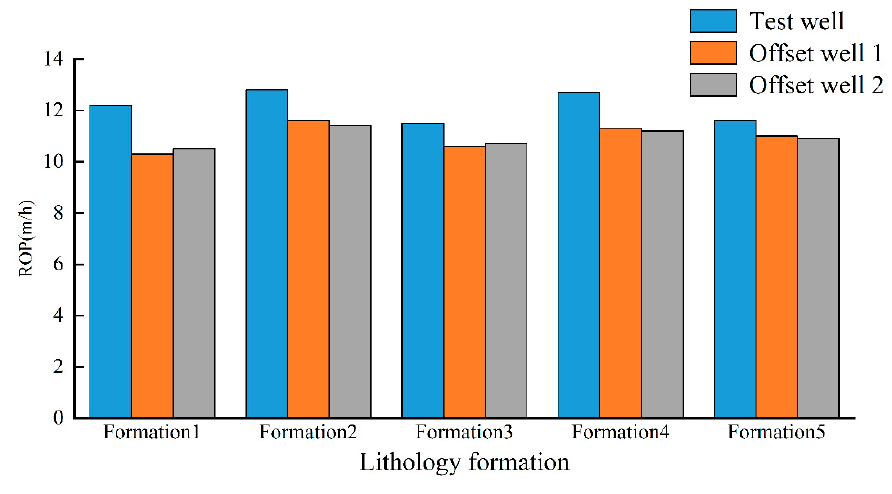
Figure 10. Lithology formation vs. average